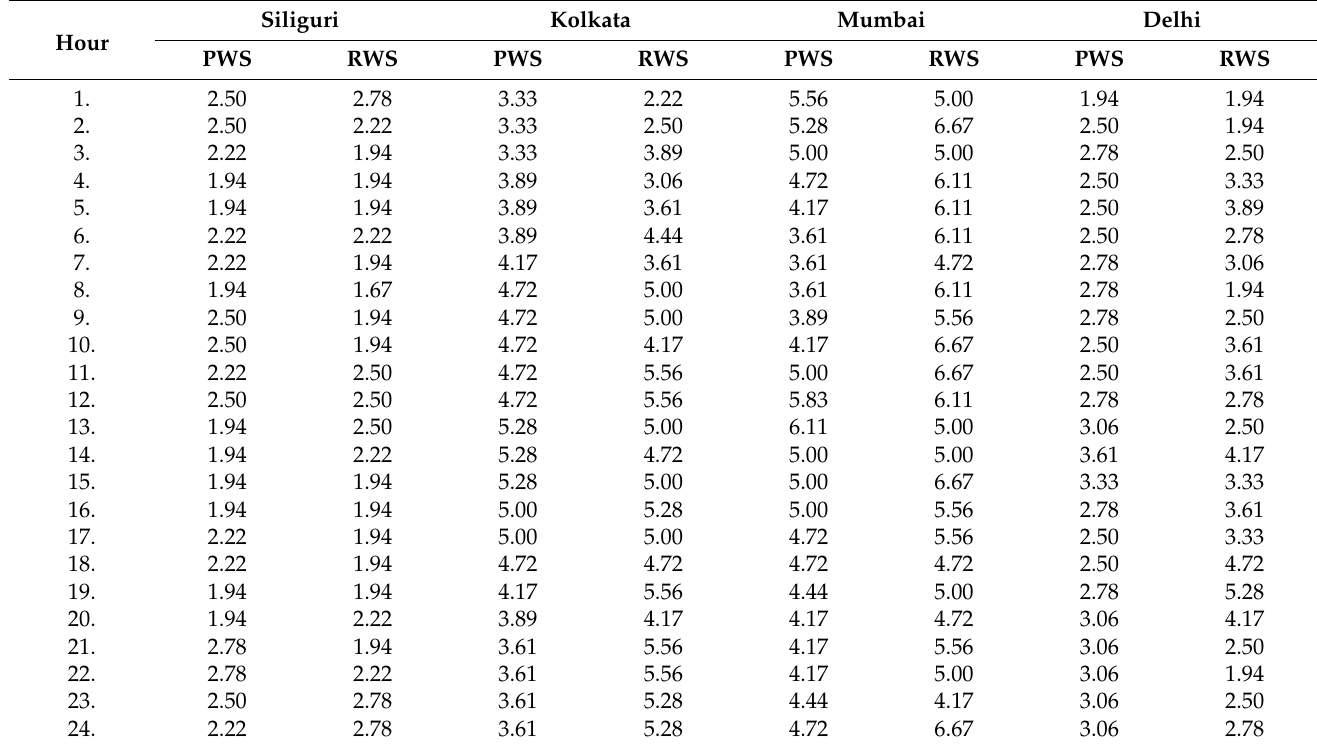
Table 1. Predicted wind speed (PWS) and real wind speed (RWS) at 10 m height (in